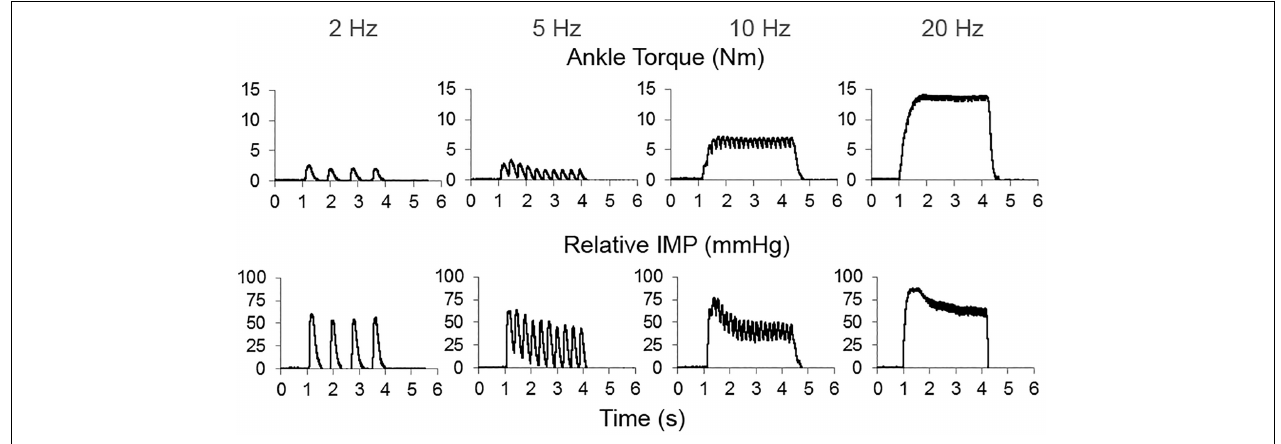
FIGURE 4 | An example of time dependent tracing of the ankle torque and intramuscular pressure (IMP) at different stimulation frequencies.